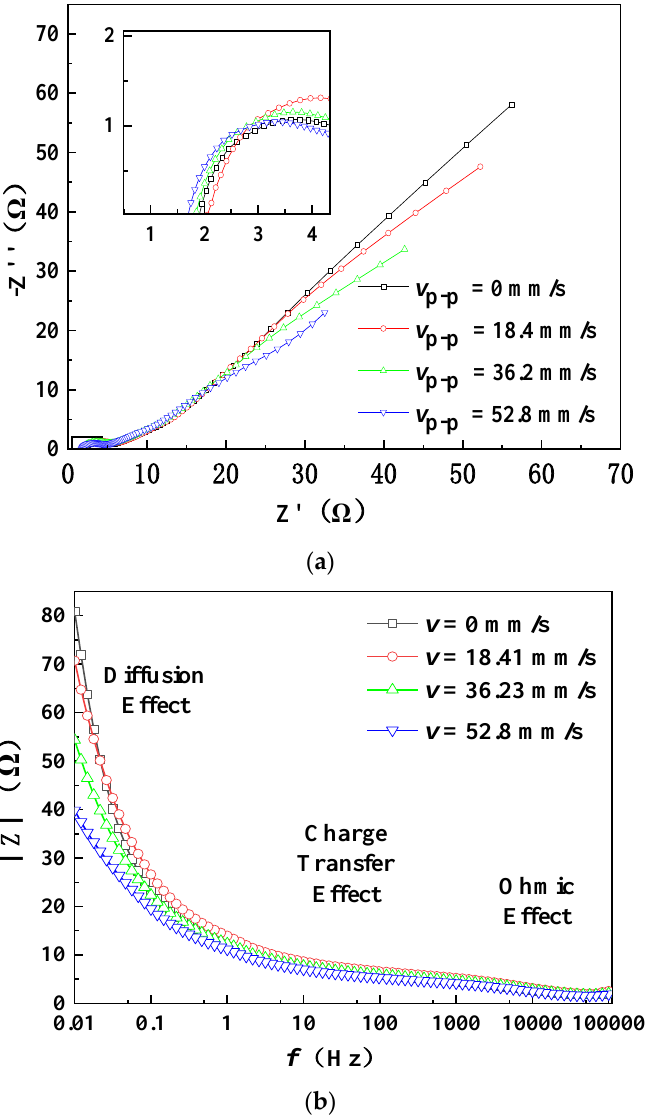
Figure 3. Measured AC impedance of the ultrasonically excited zinc – air battery under different vibration velocities at 161.2 kHz. ( a ) Nyquist plots; ( b ) Bode plots.